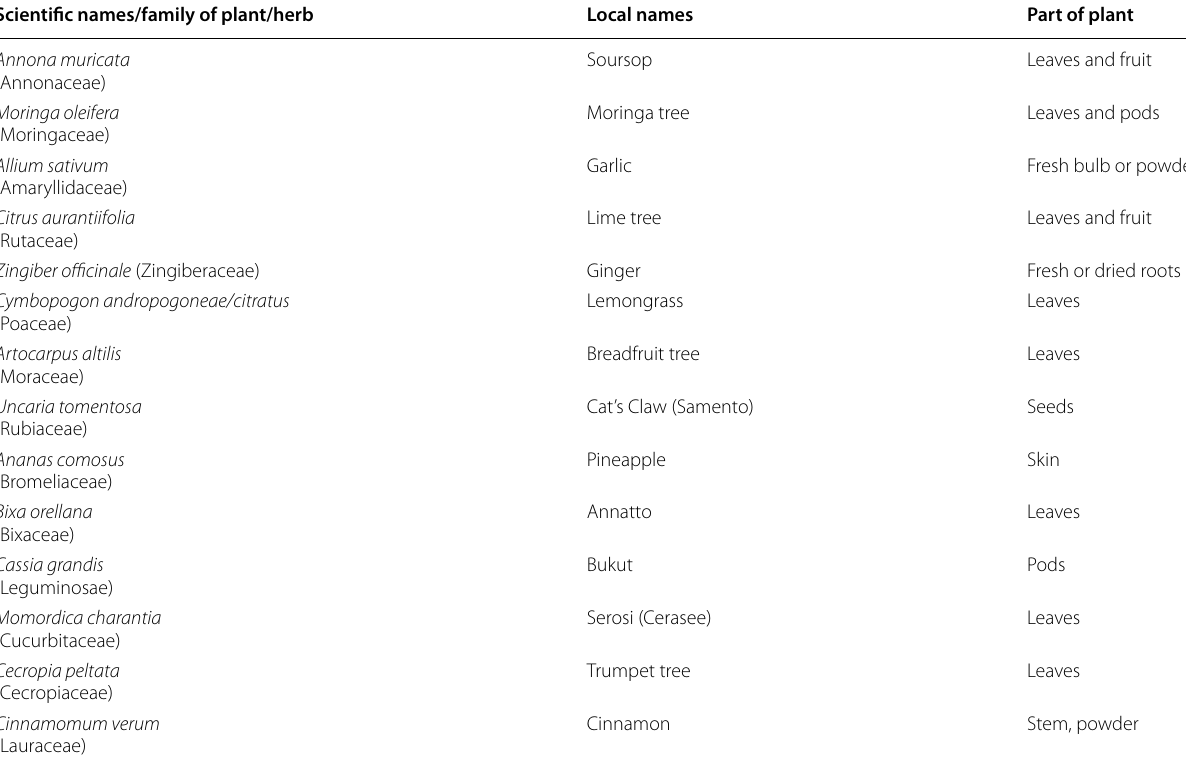
Table 2 Medicinal plants and herbs used by hypertensive patients Scientific names/family of